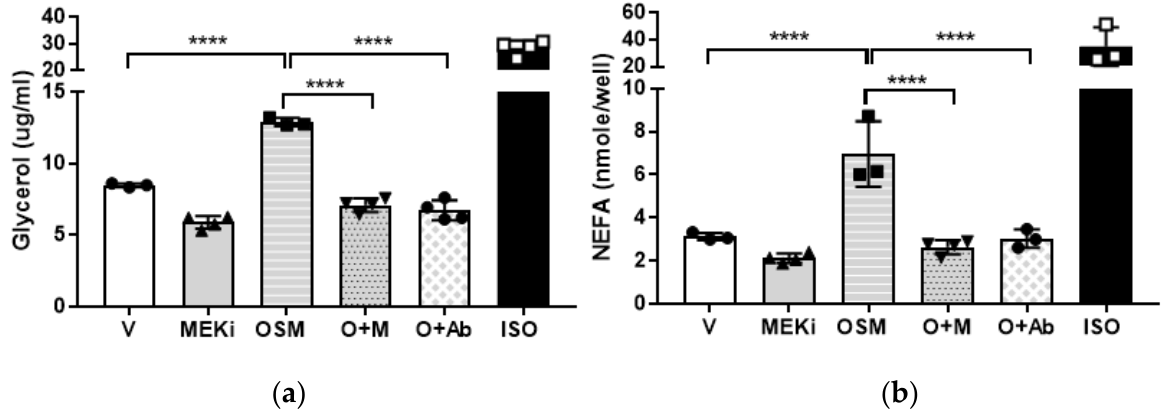
Figure 5. Pharmacological inhibition of MEK or antibody inhibition of OSMR abrogates OSM-stim- ulated adipocyte lipolysis. Fully differentiated 3T3-L1 adipocytes were pretreated with OSM in li- polysis incubation medium the night before the assay. On the day of the assay, adipocytes were incubated with or without the acyl-CoA synthetase inhibitor, triacsin C (for NEFA and glycerol measurements, respectively), plus V, the MEK inhibitor (MEKi) U0126 (50 mM), 0.5 nM OSM, OSM + U0126 (O + M), OSM + 10 μ g of anti-OSMR antibody (O + Ab), or 10 μ M ISO as a positive control, for 4 h. ( a ) Glycerol measurements were obtained from 50 μL media without triacsin C (n = 3 – 4 wells per condition). ( b ) NEFA measurements were obtained from 50 μL media containing triacsin C (n = 3 – 4 wells per condition). MEK inhibition or the addition of anti-OSMR antibody completely inhib- ited OSM-induced glycerol and NEFA release. This experiment was conducted in duplicate on a single batch of adipocytes. Significant differences are denoted as follows: **** p < 0.0001 between groups.